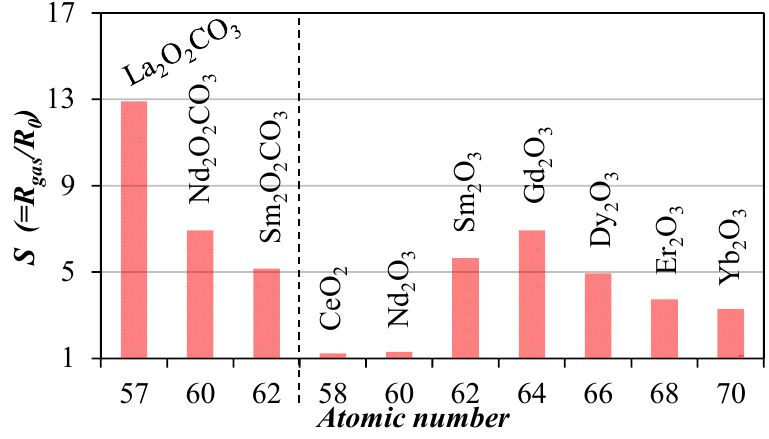
Figure 1. Comparison of sensor signal at 1000 ppm CO 2 .